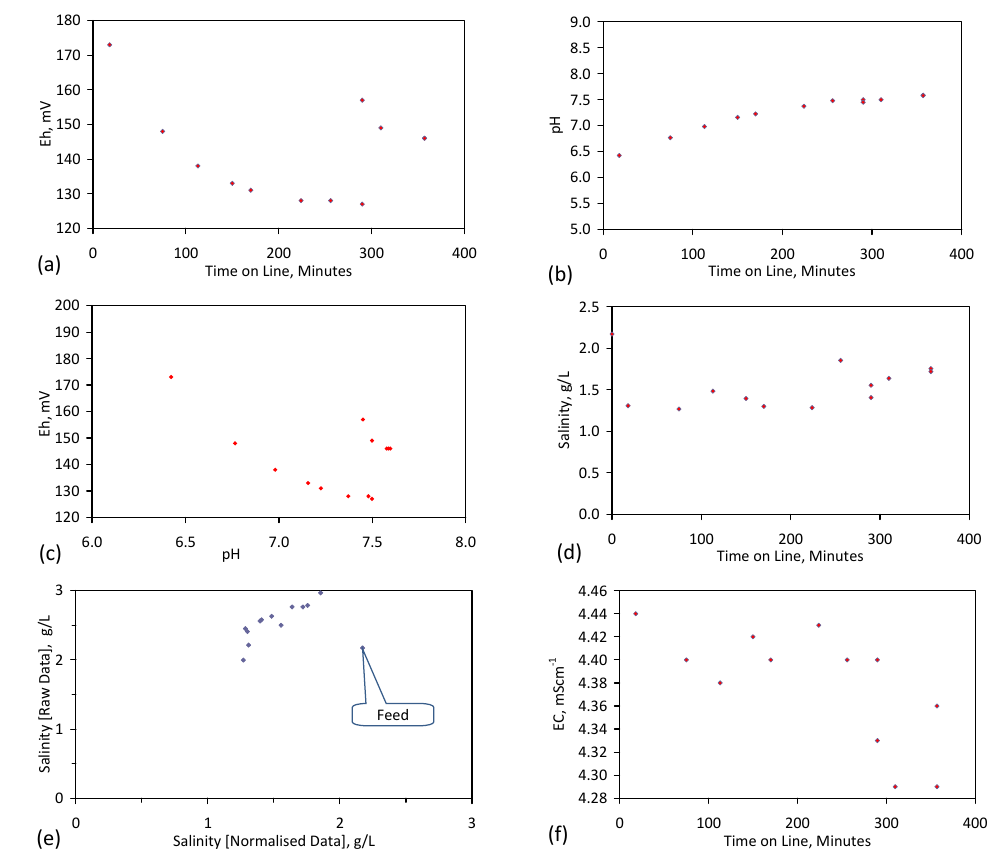
Figure C32. ZVM TPA example Trial E146. 12th Reuse; Operating Temperature: 14–20 °C; Oxidising Environment: Water volume in the reactor = 0.24 m 3 ; ZVM TPA from Trial E145 in a cartridge = 0.4 kg; Air flow = 120 L·h − 1 . Acid Oxidising Environment: Water volume in the reactor = 5.5 L; ZVM TP in a cartridge = 0.1 kg; Gas flow (80% N 2 + 20% CO 2 ) = 1.8 L·h − 1 . ( a ) Eh vs. time; ( b ) pH vs. time; ( c ) pH vs. Eh; ( d ) Salinity vs. time; ( e ) Salinity calculated from normalised data vs. salinity calculated from raw data; ( f ) EC vs.